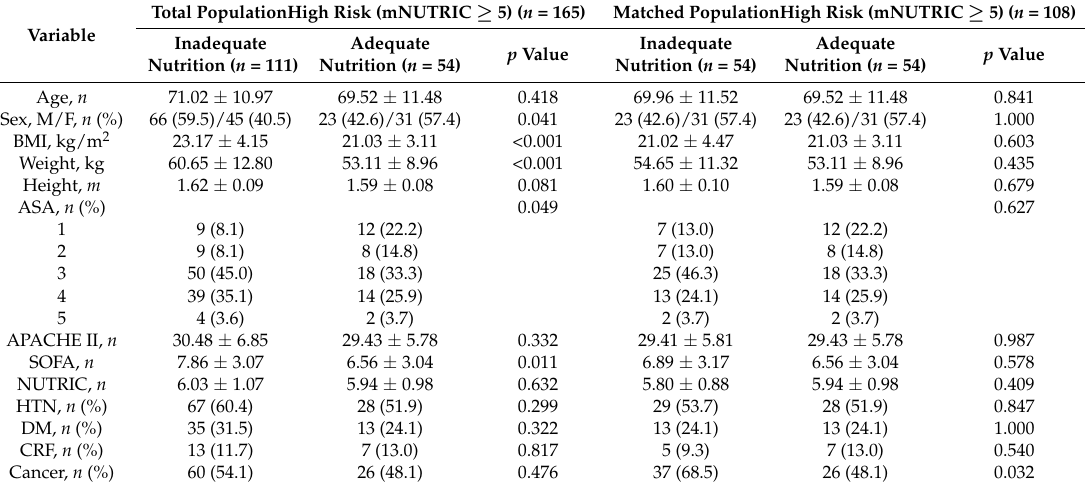
Table 1. Baseline characteristics of patients with high mNUTRIC